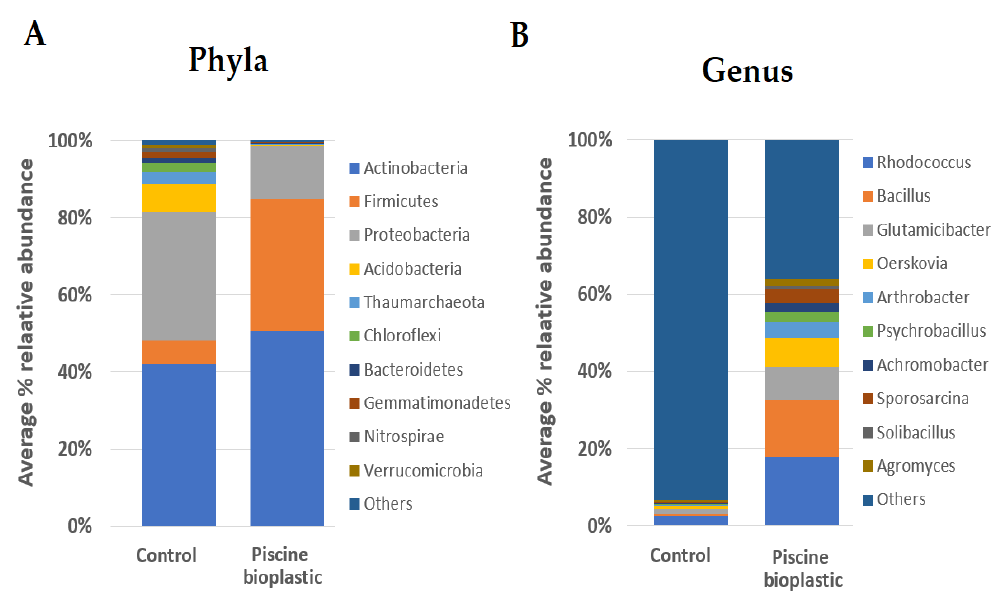
Figure 6. Top 10 phyla ( A ) and genera ( B ) identified in the control soil and the soil treated with piscine bioplastic based on % relative abundance (n = 4).